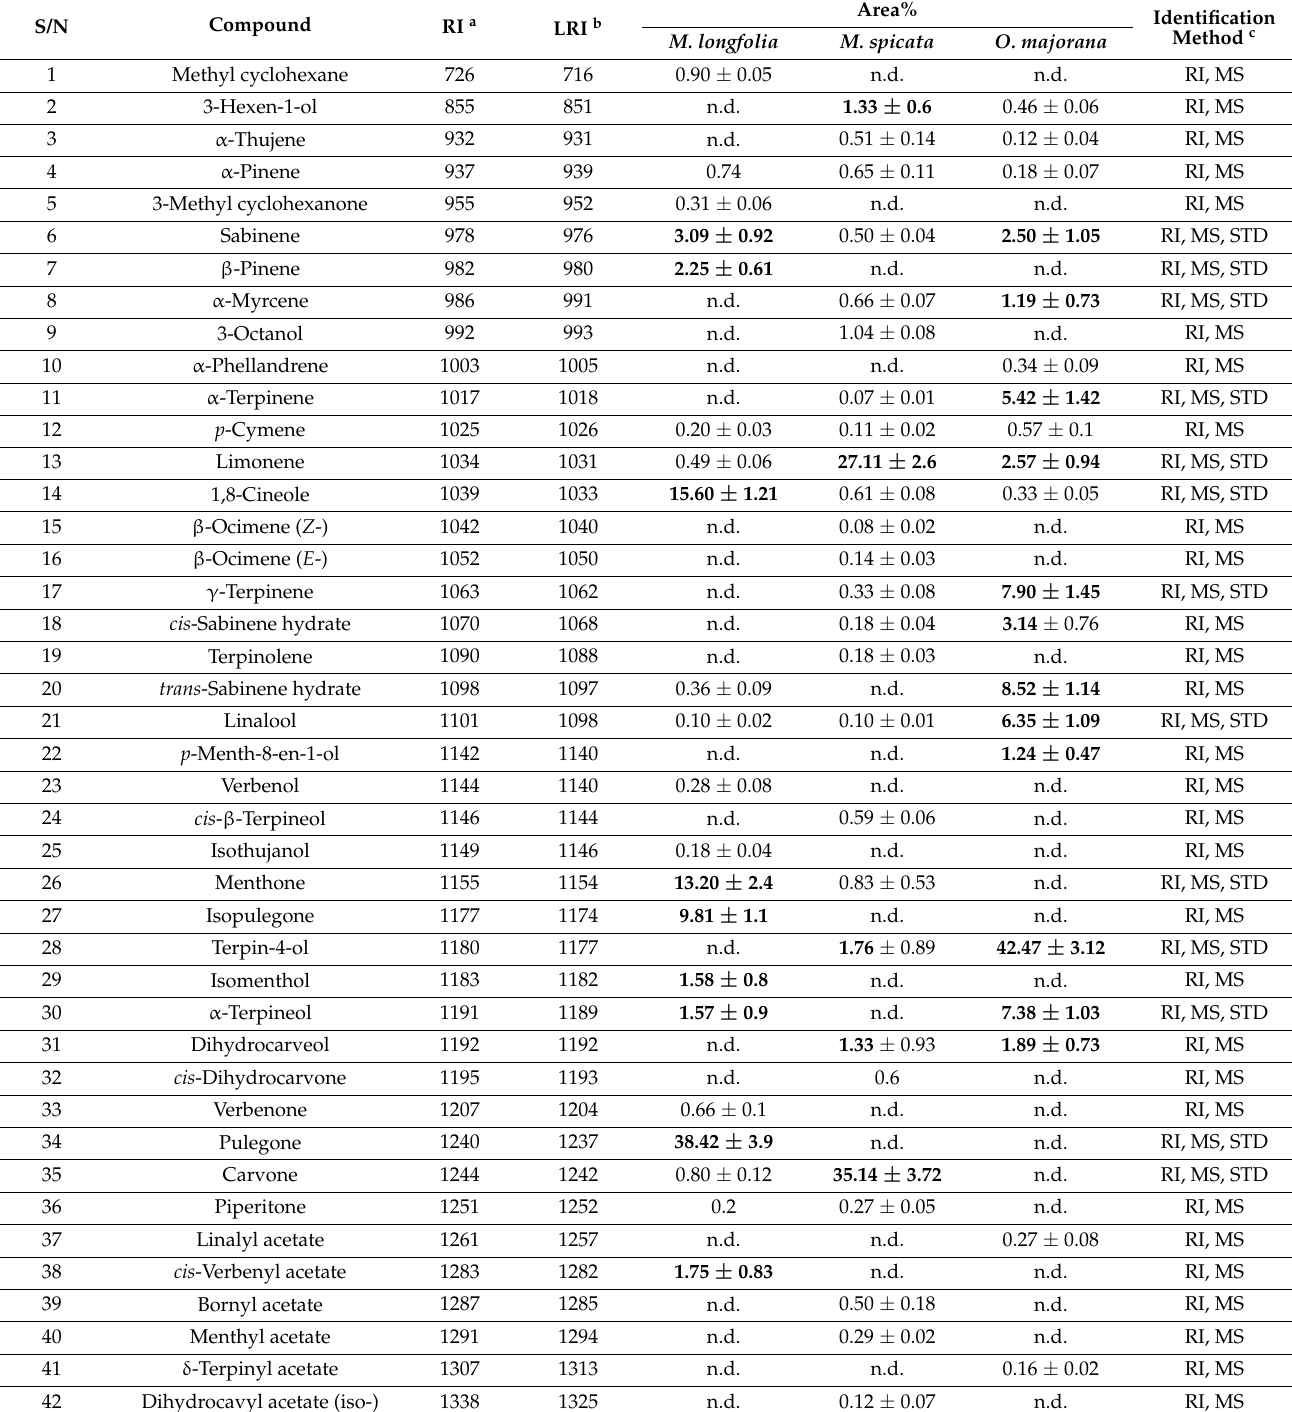
Table 1. Identification of the volatile constituents of M. longifolia , M. spicata , and O. majorana oils using